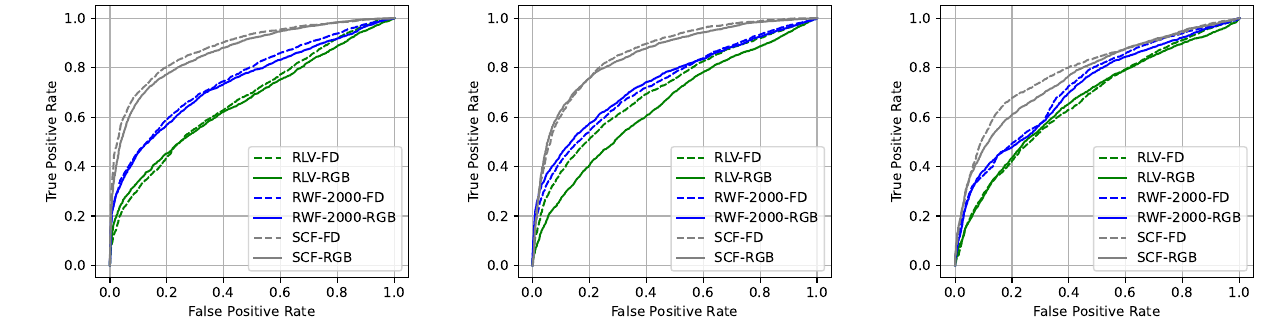
Figure 4. ROC curves concerning the three most performing pairs models/pre-training datasets, i.e., SlowFast/Surveillance Camera Fight SCF), ResNet 3D/Real-life Violent Situations (RLV), and Video Swim Transformer/RWF-2000, tested against our Bus Violence benchmark. We report the curves for both the color (RGB) and frame-difference (FD)